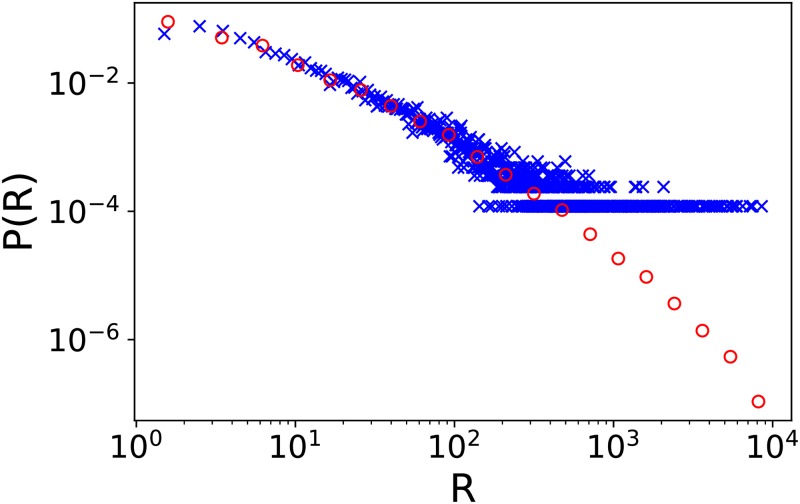
Probability distribution of number of reviews R of perfumes.The real distribution of ratings (blue crosses) follows a fat-tailed distribution. The red circles show a logarithmically binned probability distribution which acts as a guide of eye to see that there are just a few perfumes which receive a large number of reviews.